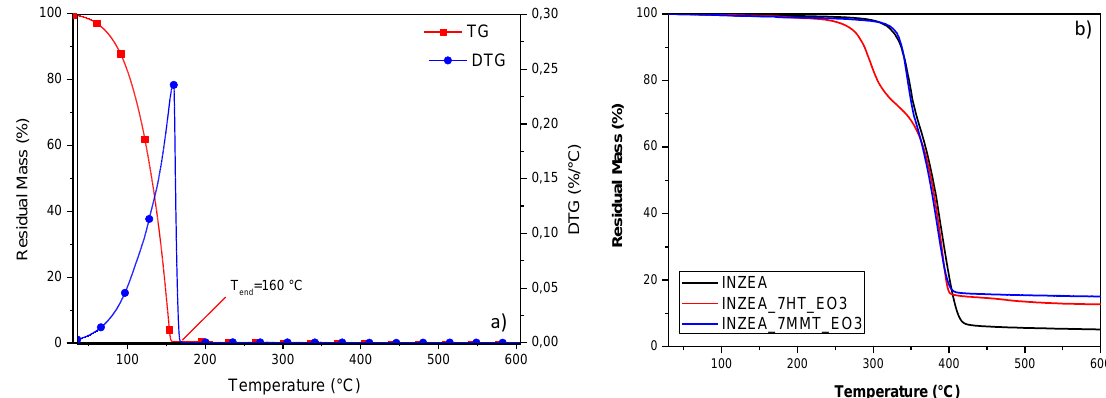
Figure 7. TGA results for pure LEO ( a ) and HT and MMT samples functionalized with 100 wt% LEO ( b ).